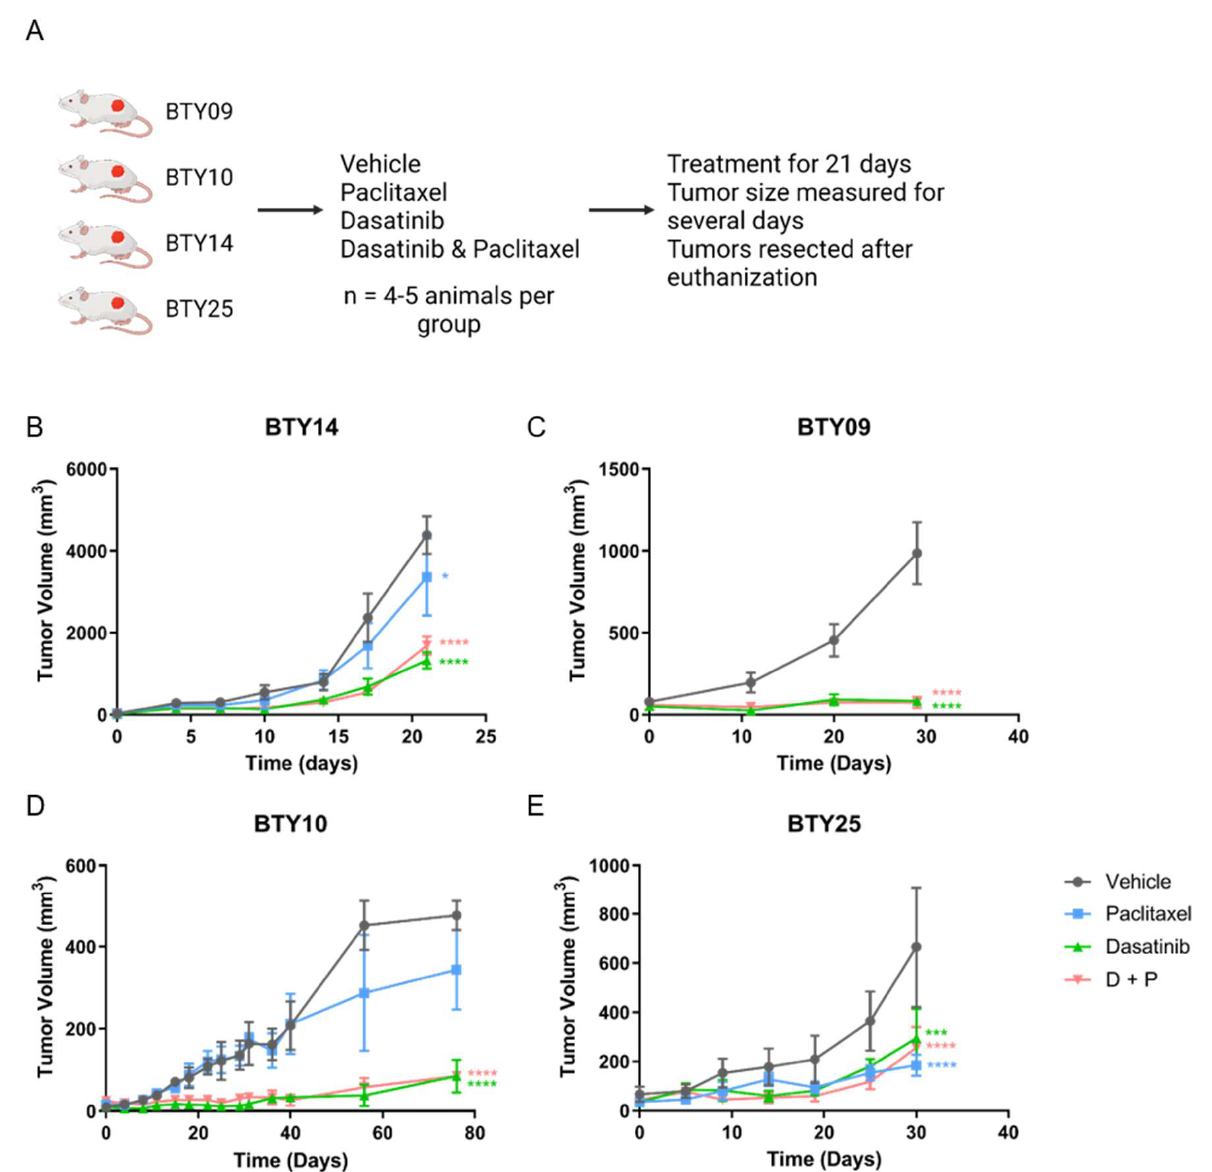
Figure 2. In vivo response to dasatinib, paclitaxel, and dasatinib + paclitaxel. ( A ) Schematic of the in vivo experiment. ( B – E ) Tumor growth response in BTY14 ( B ), BTY09 ( C ), BTY10 ( D ), and BTY25 ( E ). Tumor volume presented as average volume of xenograft tumors ± SEM (standard error of mean) ( n = 4–5/group, total 71 PDXs). Mice were treated for 3 weeks (starting at day 0) and were further monitored for several days after the treatment was stopped. Statistical significance was analyzed by 2-way ANOVA test, followed by Tukey’s multiple comparisons post hoc test. To account for multiple comparisons, p values were adjusted with family-wise significance and confidence level at 0.05 (95% confidence interval). * p ≤ 0.05, *** p < 0.001, **** p < 0.0001.